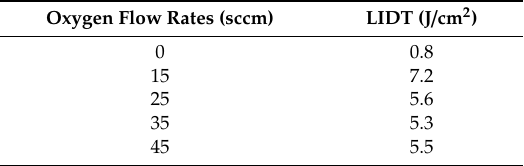
Table 1. Laser-induced damage thresholds of Sc 2 O 3 films deposited under di ff erent oxygen flow